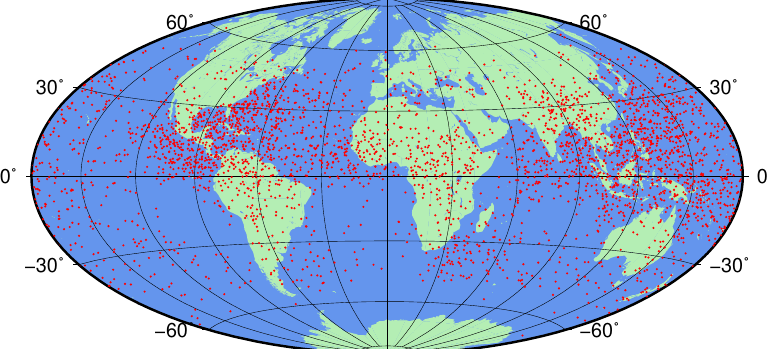
Figure 6. Geographical distribution of monotonously growing flashes measured by the TUS detector.